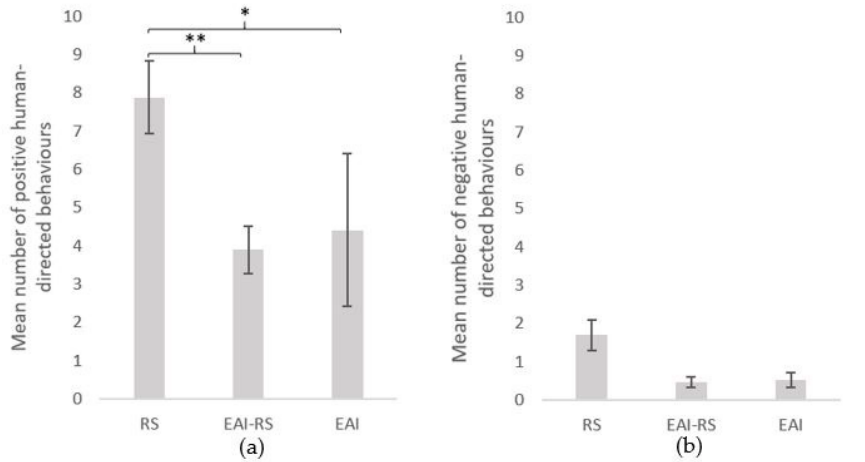
Figure 2. ( a ) Positive and ( b ) negative human-directed behaviours (mean ± SE) during the motion- less person test. Tests followed by Mann–Whitney tests as post hoc tests. RS = riding school horses (N = 95), EAI = assisted-intervention horses (N = 17), EAI-RS = horse with mixed activity (N = 60). ***: p < 0.001, **: p < 0.01, *: p < 0.05, ﮲ : p < 0.1.